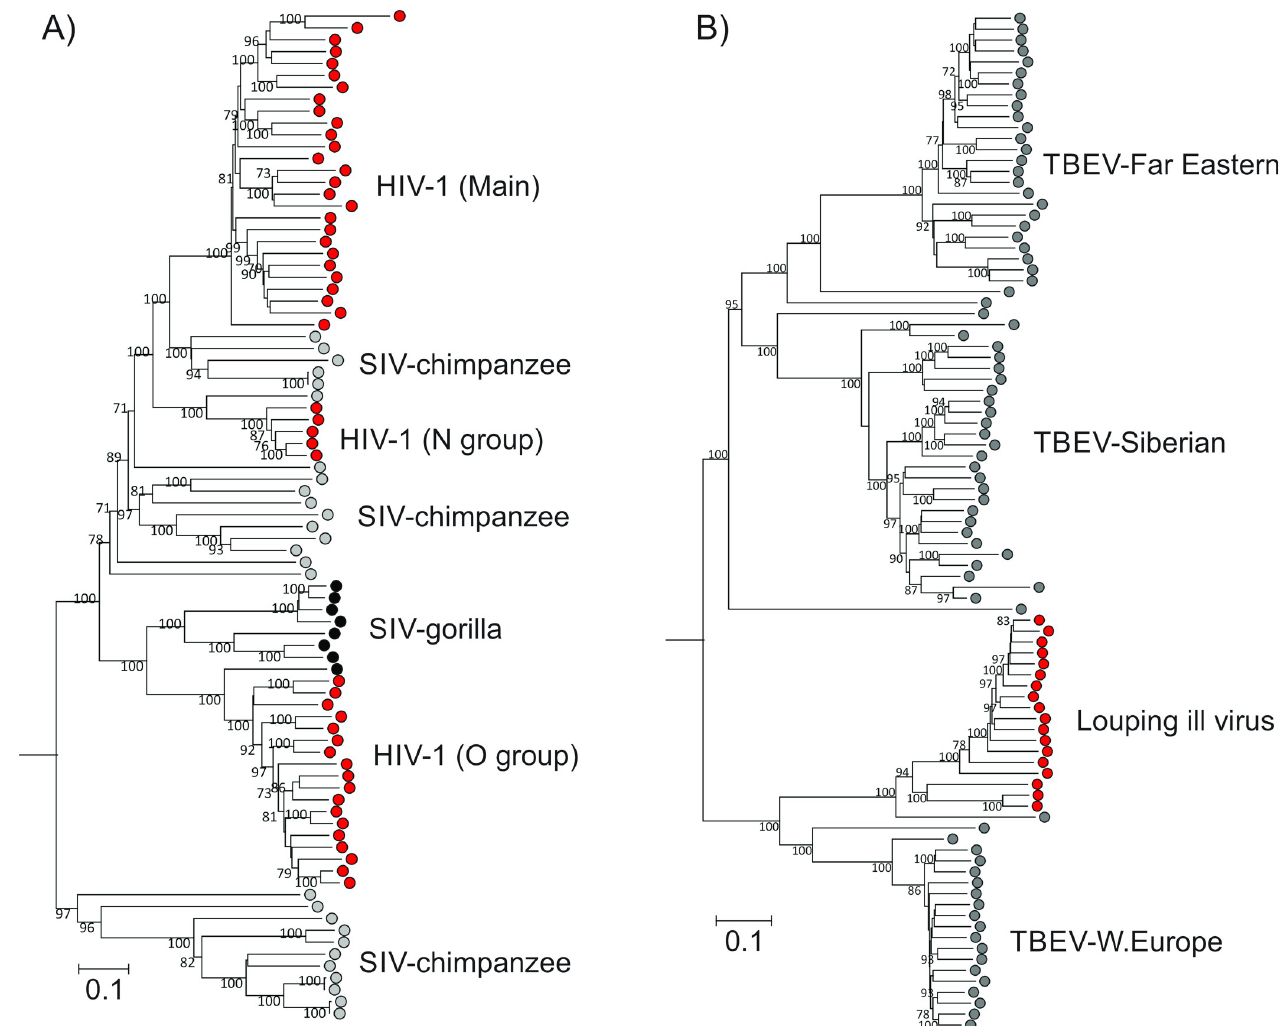
Fig 3. Examples of incompatibilities between species assignments and phylogenetic groupings. ( A ) Genetic relationships of HIV-1 (red dots) with simian immunodeficiency viruses infecting chimpanzees (gray dots) and gorillas (black dots). HIV-1 strains are polyphyletic and cannot be assigned to a single species taxon without incorporating nonhuman viruses within the definition. ( B ) Genetic relationships of louping ill virus (LIV) with tick-borne encephalitis virus (TBEV) strains isolated in Europe and Asia, with the principal groups labeled. Although LIV (red dots) is assigned to the species Louping ill virus , it lies within the phylogenetic tree created by strains of TBEV that all belong to the species Tick-borne encephalitis virus . The current assignment of LIV as a species therefore logically prevents strains of TBEV being assigned into a single species if species were to remain monophyletic. Trees were constructed from maximum composite likelihood distances between nucleotide sequences of (A) the pol gene of HIV-1/SIV and (B) the complete coding sequence of TBEV and LIV. To investigate the robustness of branches, nucleotide positions were bootstrap resampled 100 times as implemented in the MEGA7 program [91]; branches with 70% or greater support are labeled. The HIV-1/SIV tree was rooted using the HIV-2 sequence, M31113; the TBEV/LIV tree was rooted using the closely related Omsk haemorrhagic fever virus sequence, AY193805. Both trees have been annotated with a scale bar indicating substitutions per